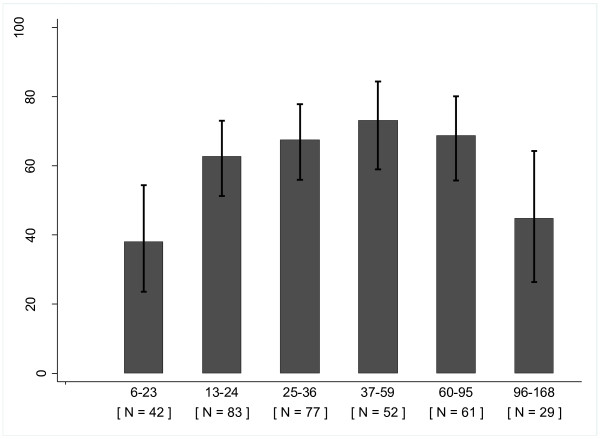
Percentage of severely malnourished children with oedema by age category in months. The error bars represent 95% confidence intervals